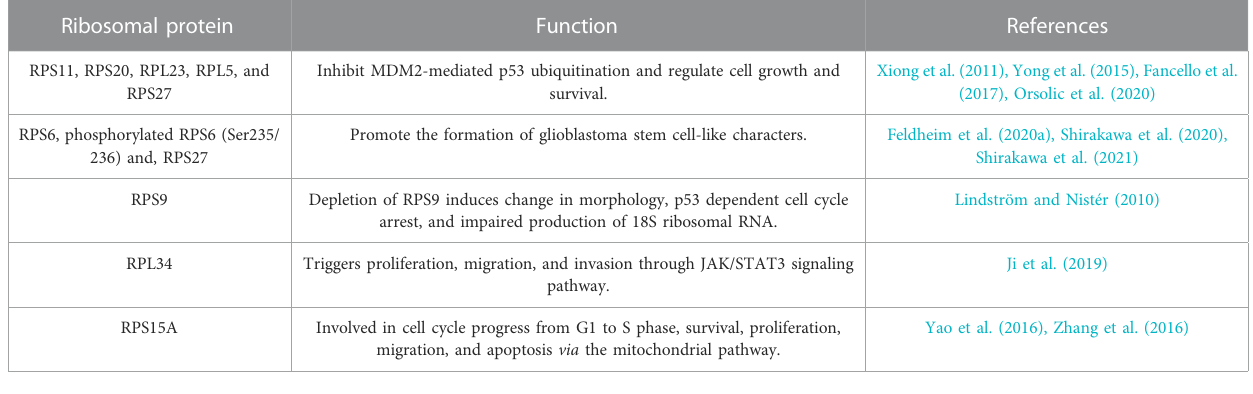
TABLE 2 Ribosomal proteins involved in GB progression. Ribosomal protein Function